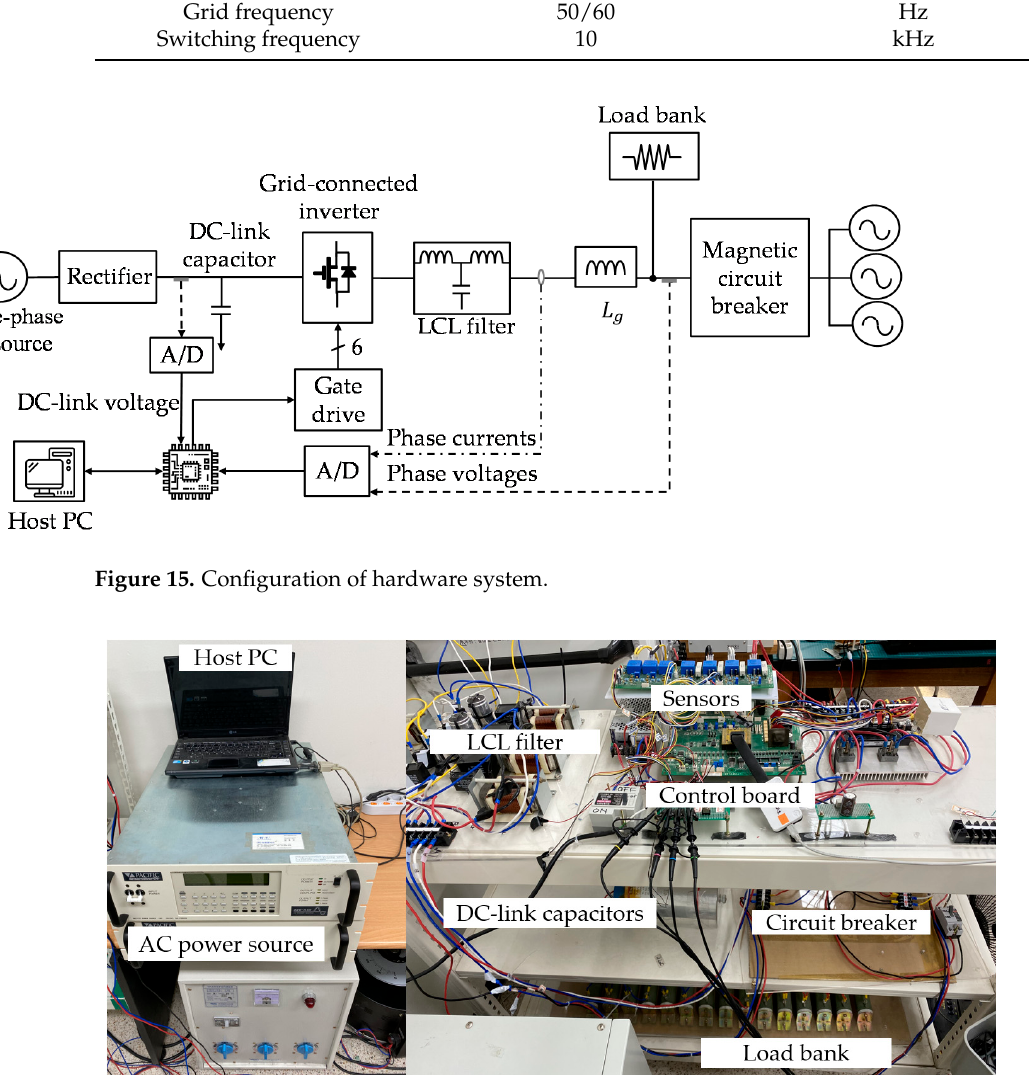
Figure 16. Experimental test setup.